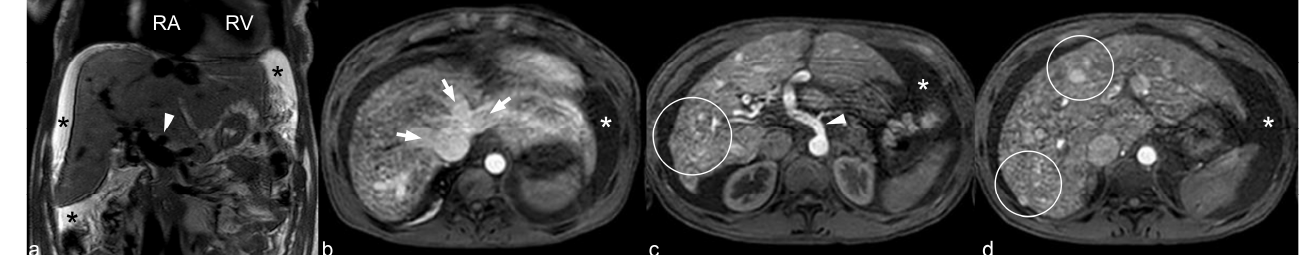
Figure 4. Abdominal MR. Coronal SSh image ( a ) and axial images on the arterial phase ( b – d ). Hepatomegaly and free abdominal fluid are seen (Black asterisk on ( a ) and white asterisk on ( b – d ). The hepatic veins as well as the inferior vena cava are dilated and show early enhancement (white arrows) due to extensive arteriovenous shunts and heterogeneous enhancement (within white circles). Due to these shunts the hepatic artery is dilated (white arrowheads) and multiple arteries are seen on the liver hilum. SSh: Single Shot.